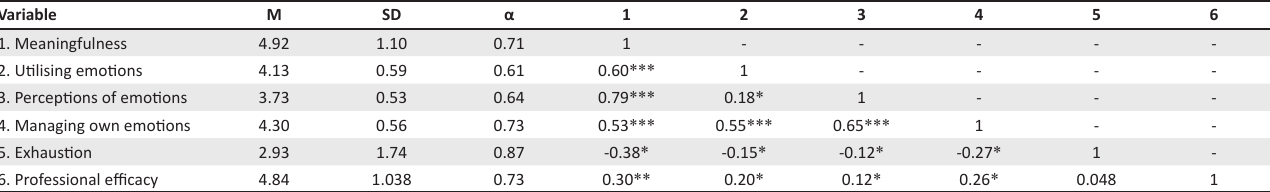
TABLE 1: Descriptive statistics and bi-variate correlations ( N = 409). Variable M SD